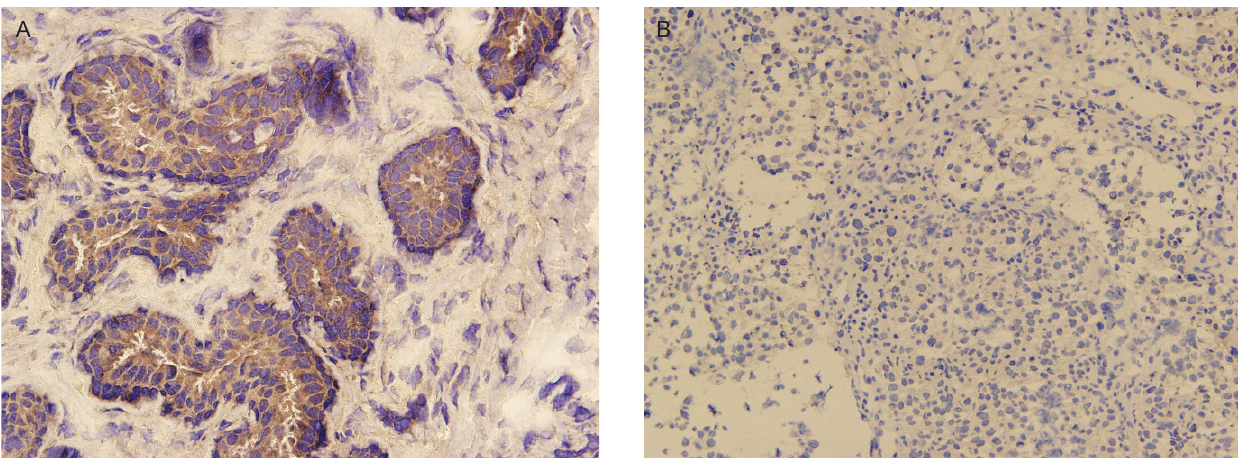
Figure 2 - The presence (a) and absence (b) of VEGF-C expression in breast cancer cells (Anti-VEGF-C antibody mouse isotype IgG2 b , k